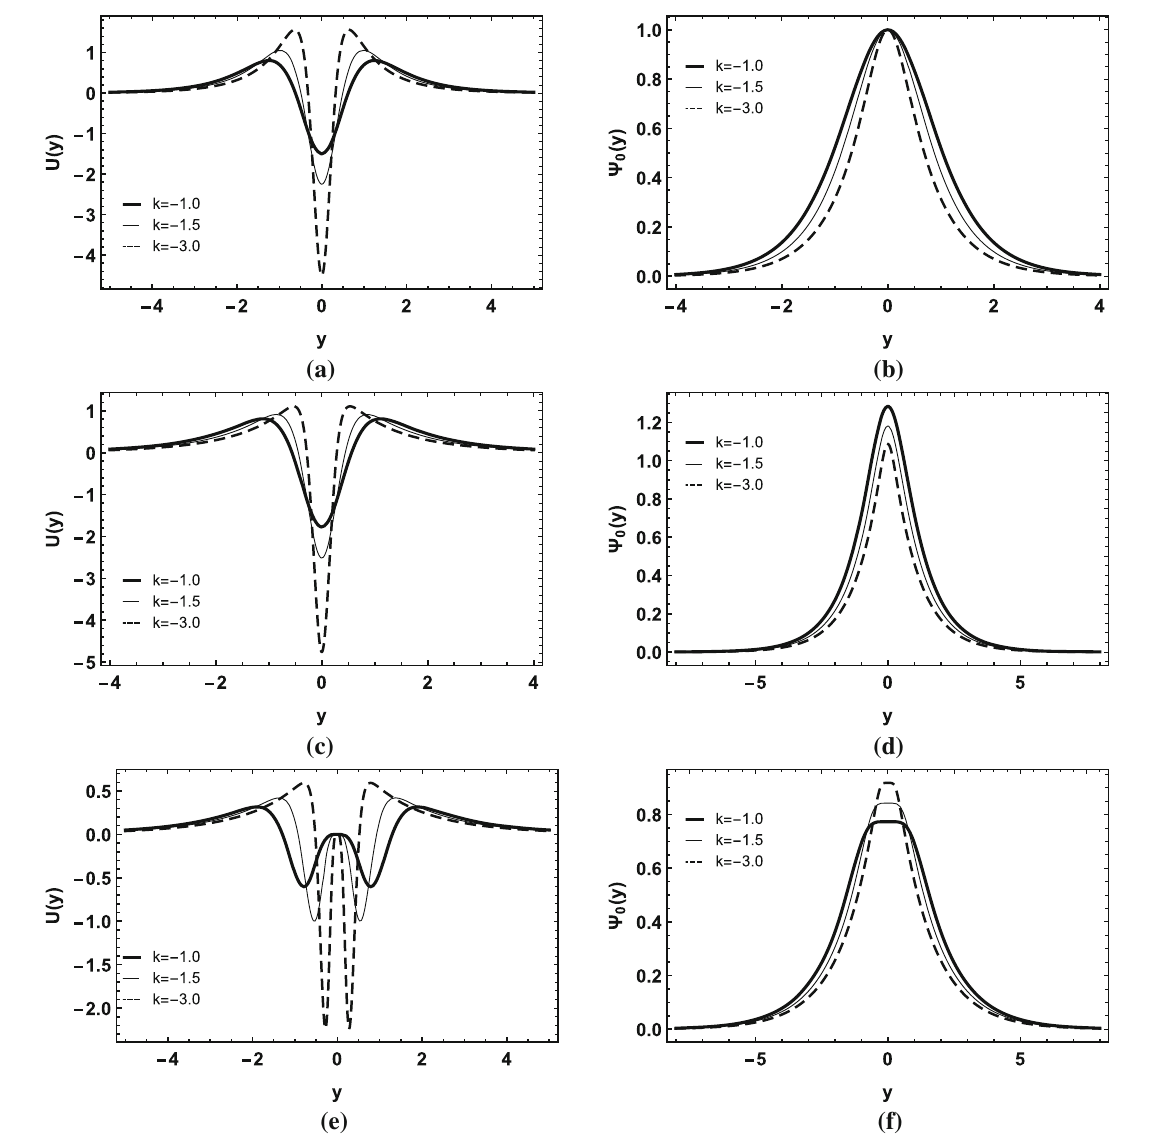
Fig. 10 Plotsoftheeffectivepotential,andzeromodefor n = 1and k 0 = α = β = 1. a , b Periodicalsuperpotential. c , d Polynomialsuperpotential. e , f Fractional